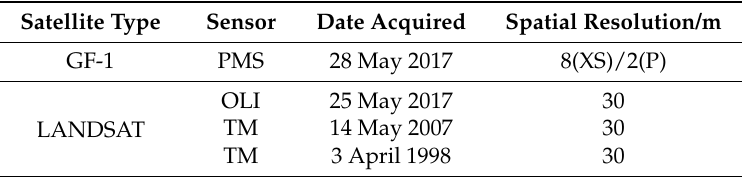
Table 1. Remote sensing data source.